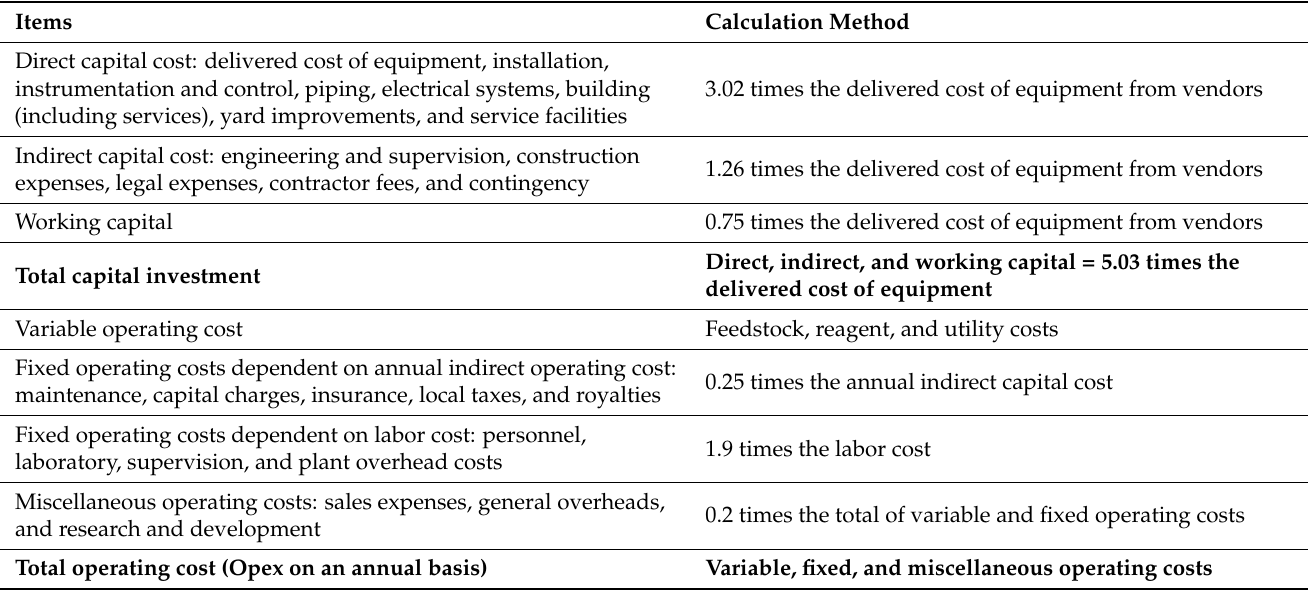
Table 3. Capital and operating cost